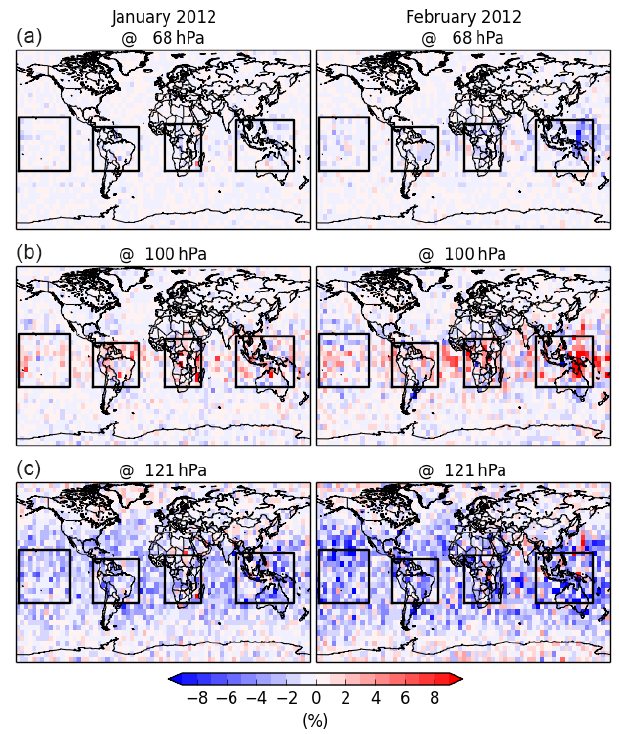
Figure 16. Relative difference between the H 2 O fields from the ob- servation and the assimilation in January 2012 (left) and in February 2012 (right) at 121hPa (c) , 100hPa (b) and 68hPa (a) .